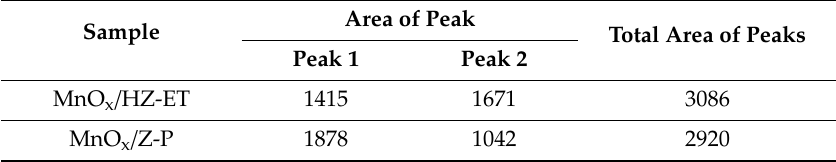
Table 4. The NH 3 desorption of the catalysts.